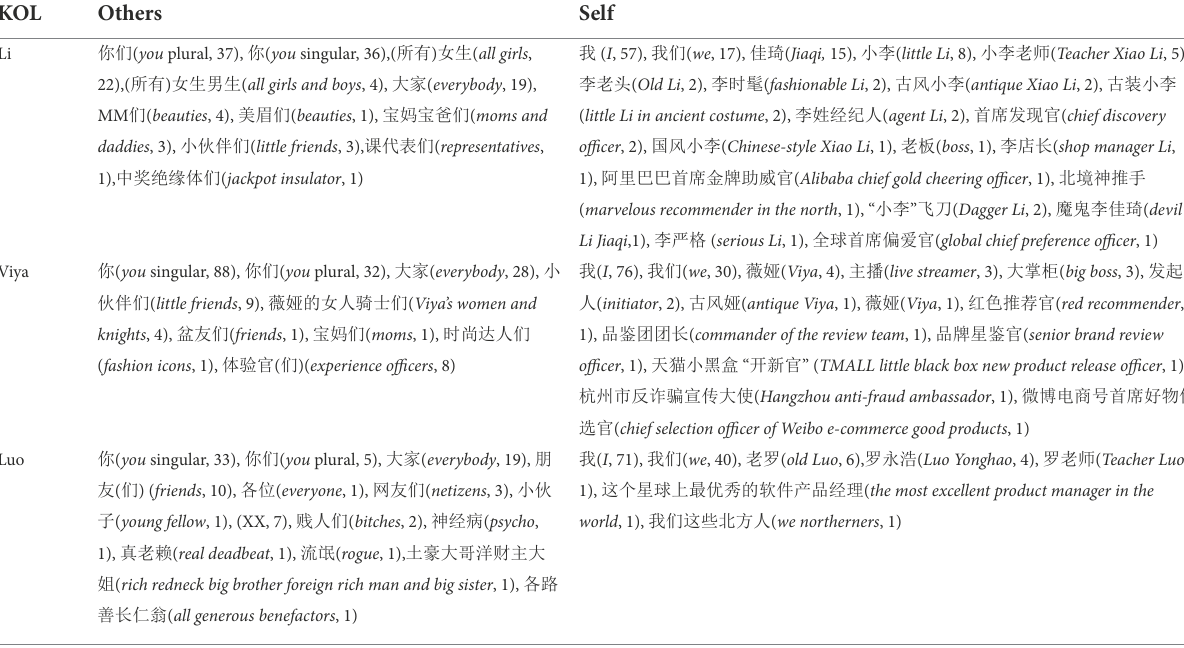
TABLE 7 Addressing terms of KOLs.